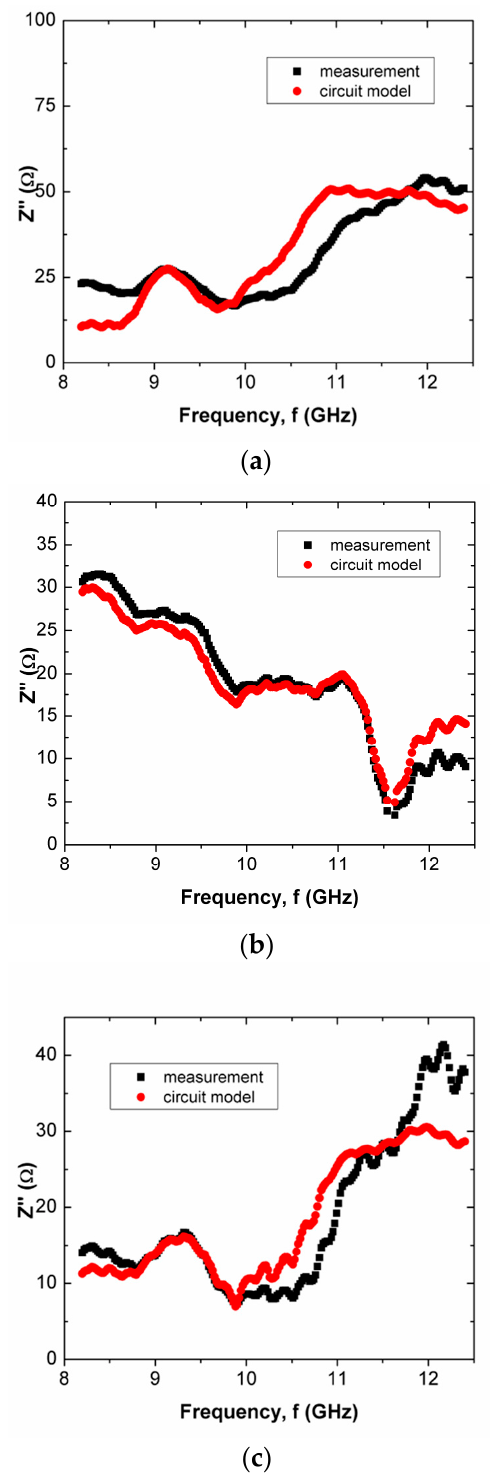
Figure 6. Comparison between measured and simulated Z” (imaginary part of impedance) of scaffold composites with ( a ) 50% Wangi rice starch and 50% nHA, ( b ) 60% Wangi rice starch and 40% nHA and ( c ) 70% Wangi rice starch and 30% nHA, at X-band.